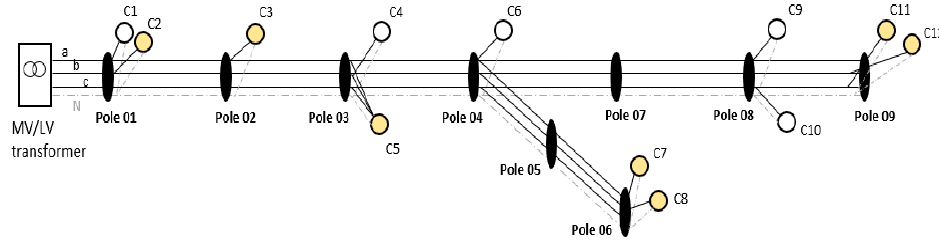
Figure A1. A LV distribution network example. Table A1. The matrix DataIN written for the LV distribution network depicted in Figure A1.